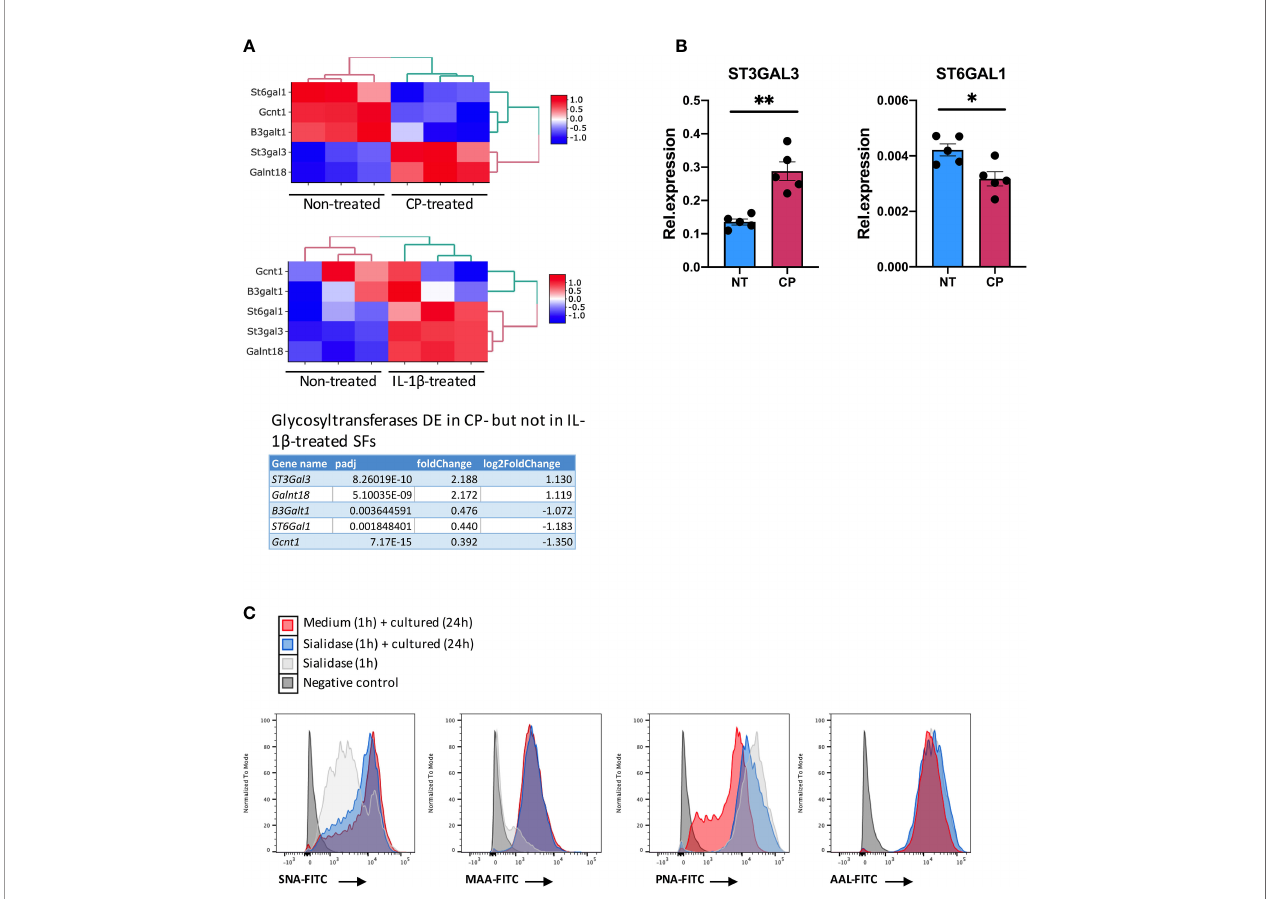
FIGURE 7 | Enzymatic removal of sialic acid modulates intracellular sialyltransferases expression. (A) mRNA expression in SFs as detected by RNA-Seq from Figure 6 for ST6Gal1, ST3Gal3, Gcnt1, B3Galt1 and Galnt18, including gene expression following C. perfringens sialidase treatment or IL-1 b stimulation. Table shows adjp value and fold change of the glycosyltransferase genes, signi fi cantly regulated (adjp < 0.01, |log2Foldchange| >1) in C. perfringens sialidase treated SFs but not in in IL-1 b -stimulated SFs. (B) RNA was extracted from control and C. perfringens sialidase treated naïve SFs. Relative expression of ST3gal3 and ST6gal1 was evaluated by RT-qPCR. Each dot represents one independent experiment, error bars represent SEM (n = 5), *p < 0.05, **p < 0.01 by Mann-Whitney test. (C) The presence of sialic acid on control and C. perfringens sialidase treated naive SFs was examined by fl ow cytometry for the binding of SNA, MAA, PNA and AAL. Experiments were performed after treatment (T0) and 24-hour incubation after treatment